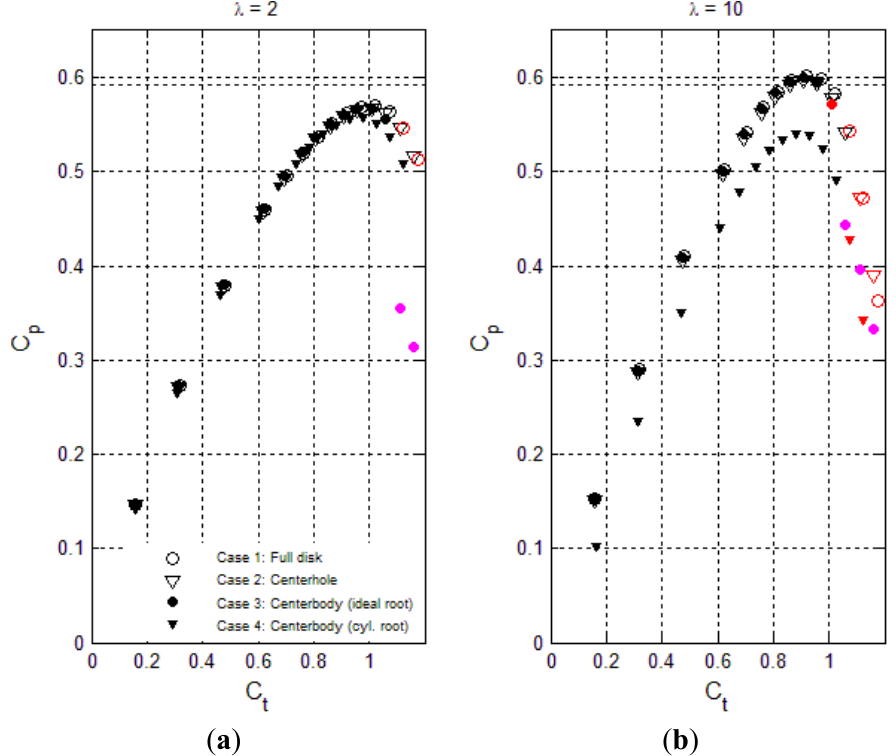
Figure 15. Rotor C T – C P performance plots for four different HAWT nacelle/rotors.